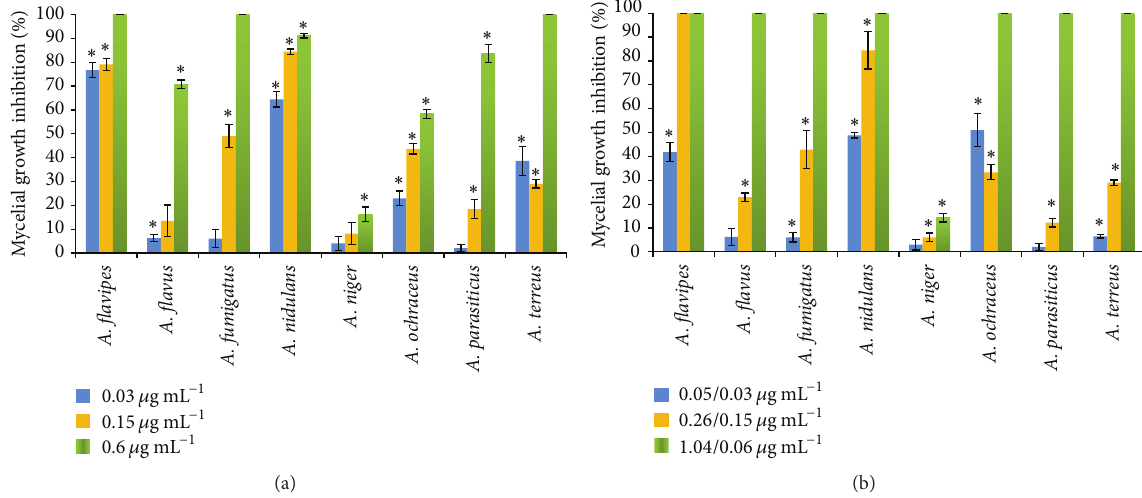
Figure 4: Mycelial growth inhibition in 21-day-old Aspergillus spp. cultures treated with benzalkonium chloride concentra- tions of 0.03 𝜇 gmL −1 , 0.15 𝜇 g mL −1 , and 0.6 𝜇 g mL −1 (a) and fullerenol/benzalkonium chloride concentrations of 0.05/0.03 𝜇 gmL −1 , 0.26/0.15 𝜇 g mL −1 , and 1.04/0.6 𝜇 gmL −1 (b). Results are expressed as means ± standard error of values obtained from triplicate experiments ( ∗ 𝑝 < 0.05 ).